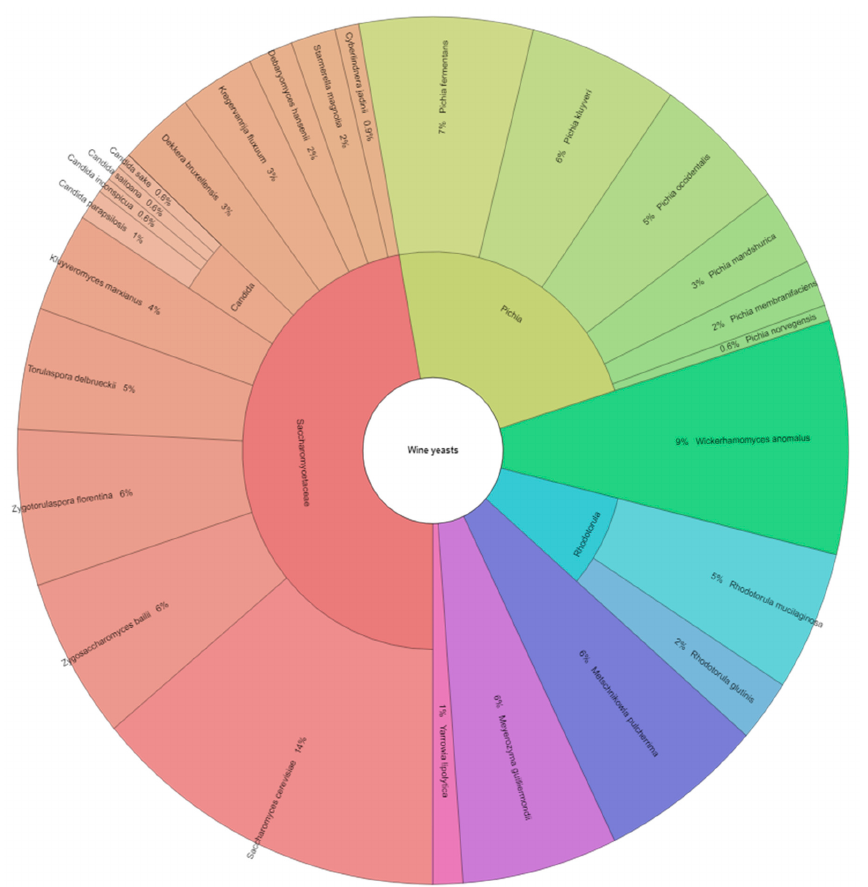
Figure 3. Yeasts isolated from the wine.